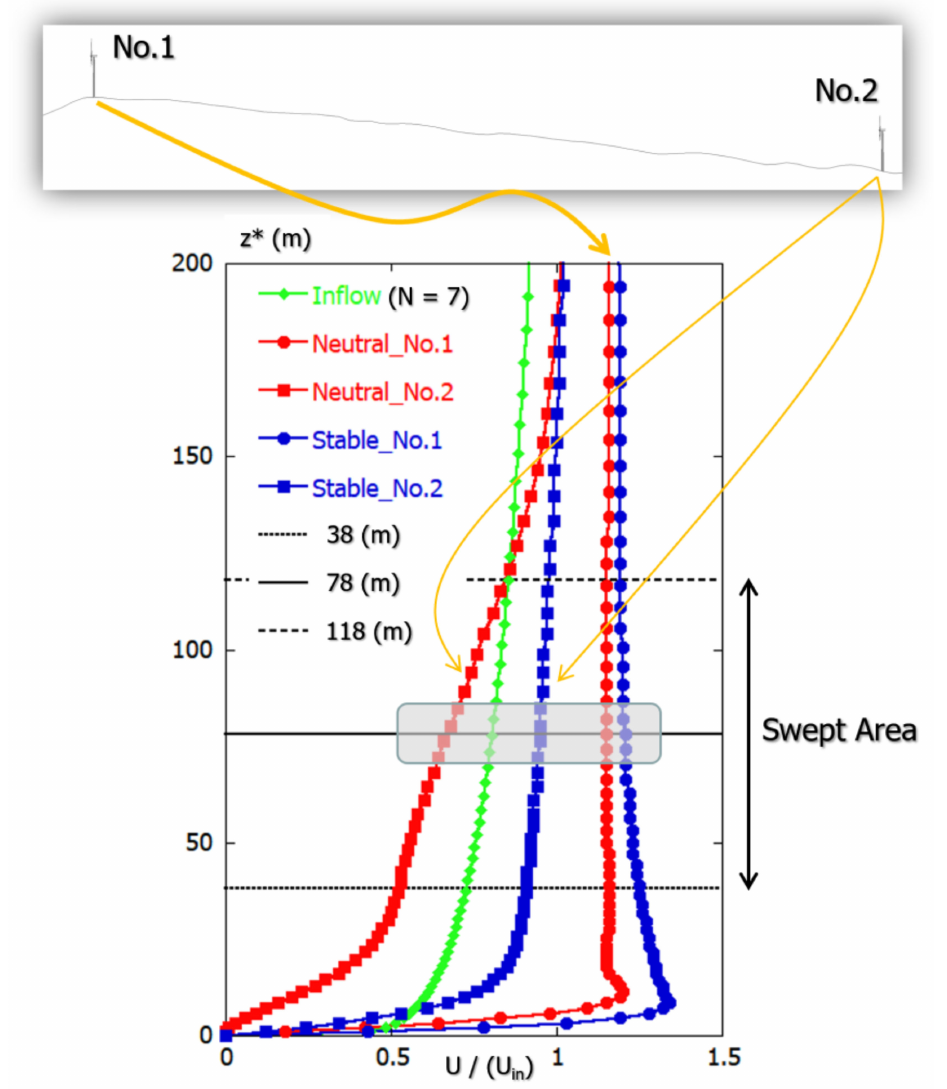
Figure 23. Vertical distribution of the time-averaged U-velocity at the No. 1 and No. 2 wind turbines in the neutral stratified state (Ri = 0.0) and the strongly stable stratified state (Ri = +